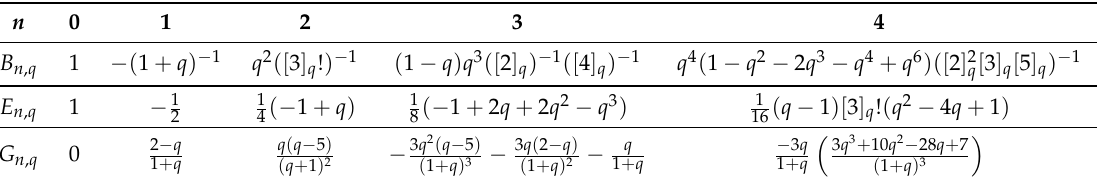
Table 2. Values of first five B n , q , E n , q and G n , q